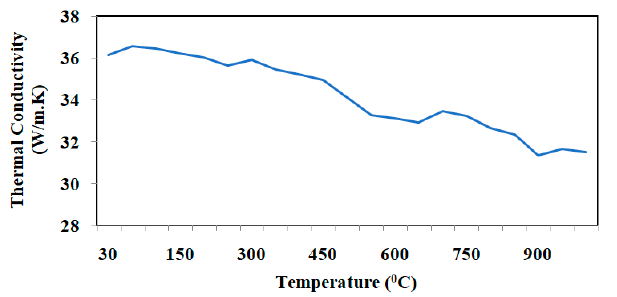
Figure 14. Thermal conductivity versus temperature plot of Ti-6Al-4V-SiC(15 Wt.%) processed under aging temperature (1150 °C), aging time (four hours), heating rate (5 °C/min), and cooling rate (5 °C/min).